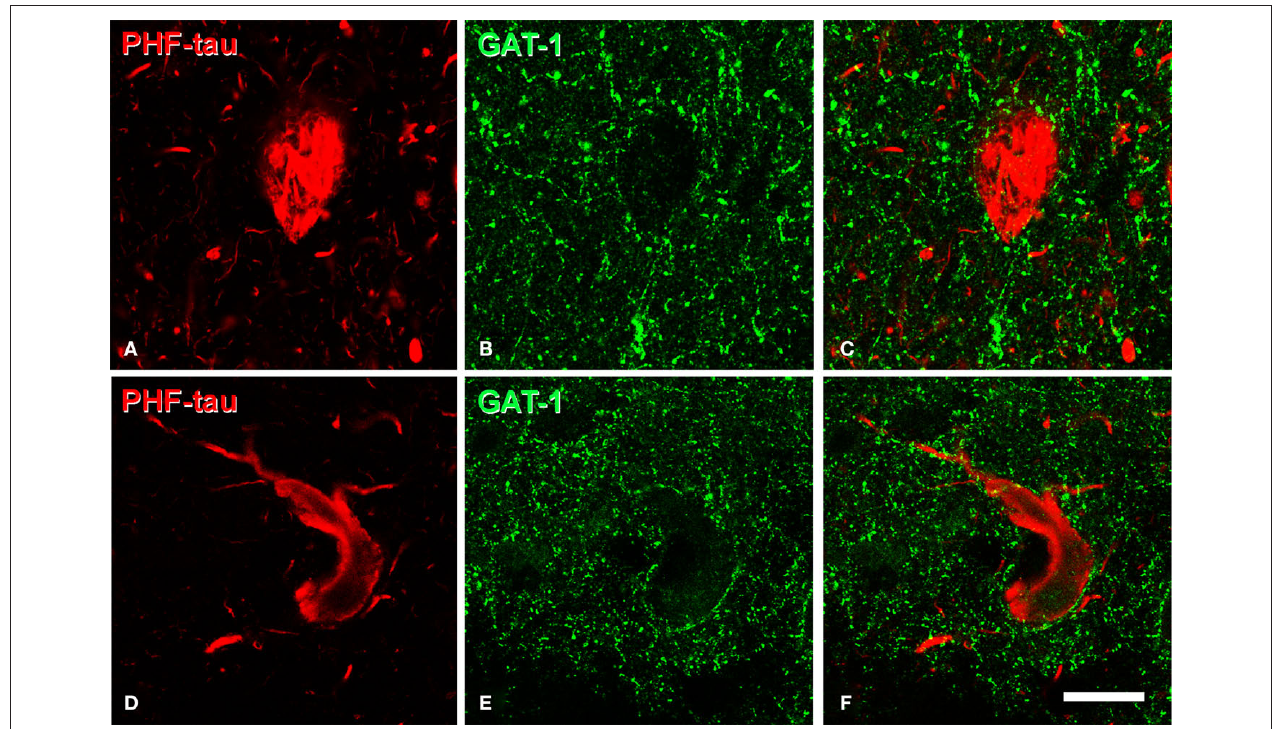
FiGure 11 | (A,B), (D,e), pairs of confocal images from the same section and field to illustrate the presence of GAT-1-ir axon terminals (green) around the cell bodies of PHF-tau-ir neurons with type II staining (red) in the entorhinal cortex